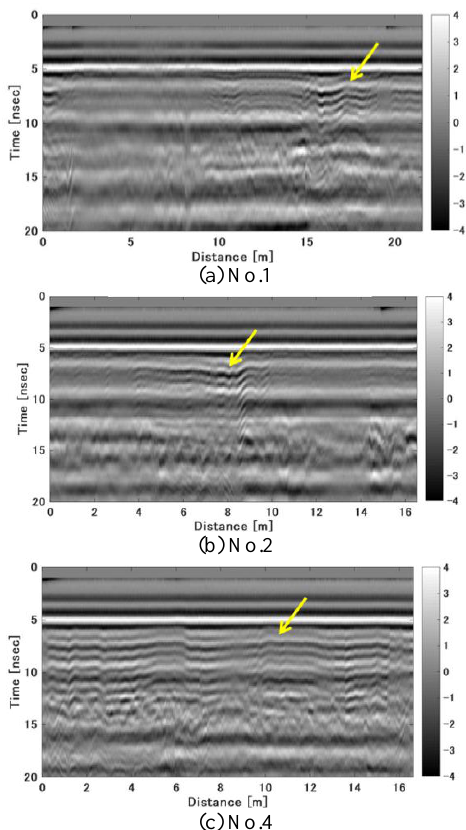
Figure 5. Bscan image obtained from 600MHz